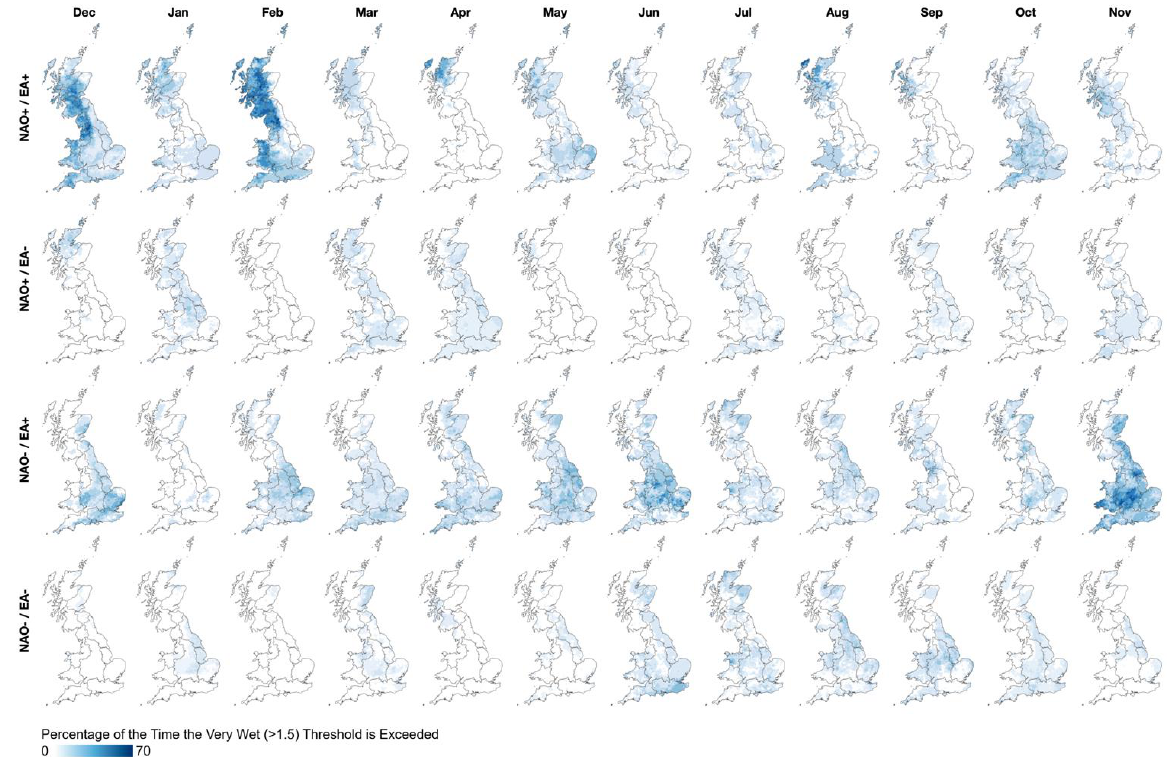
Figure 8. Percentage of time the very wet (SPI-1 > 1.5) SPI-1 class threshold is exceeded under different phase combinations of the NAO and EA.